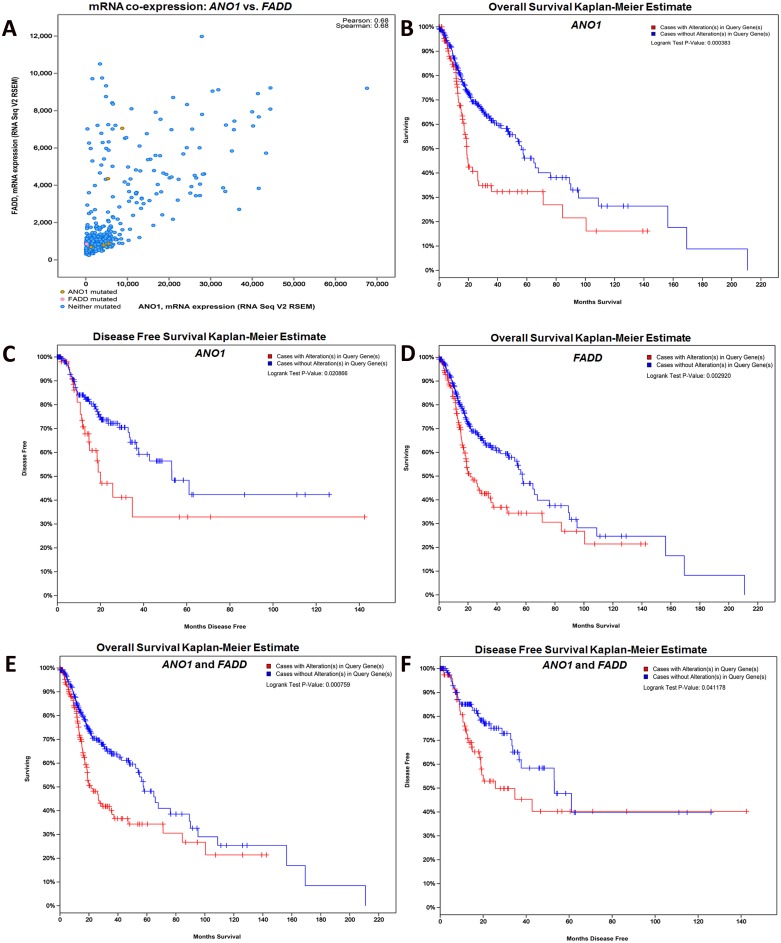
Validation with the TCGA database.The selected markers were analyzed in the TCGA database for the co-expression, overall survival and disease free survival for their significance in the HNSCC TCGA provisional study. ANO1 and FADD showed highest correlation in the co-expression analysis (A) with Pearson’s and Spearman’s correlation (0.68). ANO1 and FADD were further analyzed for their overall survival (OS) (B and D) and Disease free survival (DFS) (ANO1; C). Patients with ANO1 over-expression showed low median survival (18.96 vs 56.44 months; p = 0.0003) and low DFS (20.04 vs 53.09 months; p = 0.02) when compared with the cohort without alterations (B and C). FADD showed association with OS wherein low median survival (21.48 vs 57.42; p = 0.002) was observed in patients with an upregulation of the gene (D). Both ANO1 and FADD when assessed in combination, were associated with low median survival (21.48 vs 57.88; p = 0.0007) (E) and disease free survival (25.72 vs 53.09; p = 0.04) (F) in altered cases when compared to cases without alterations.